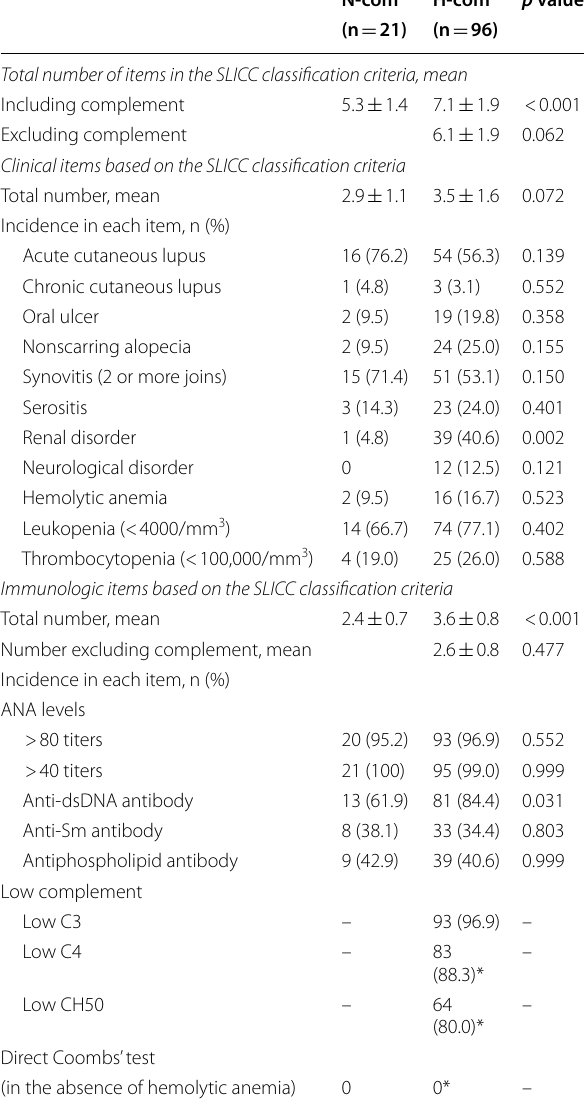
Table 3 Inclusion items in the SLICC classification criteria in patients with normal and low serum complement levels